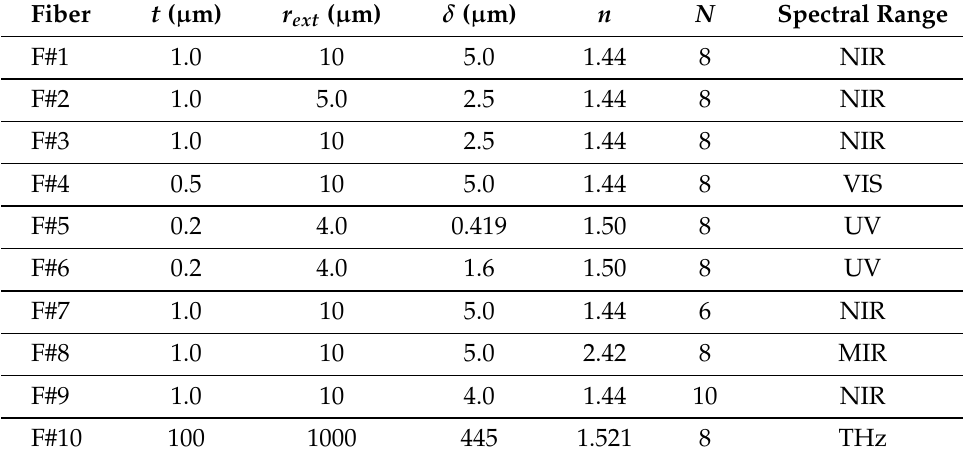
Table 1. TLF design parameters for different spectral ranges. The fibers are the same ones considered for testing the CL formula in [24].